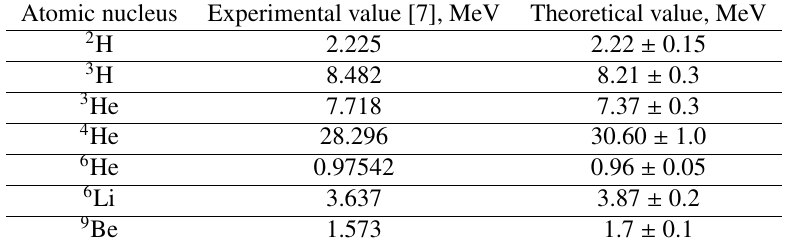
Table 1. Comparison of theoretical and experimental binding energies for the ground states of the studied